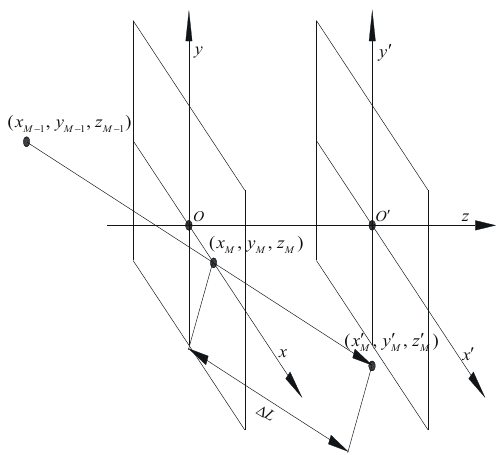
Figure 1. Schematic of arriving coordinates of